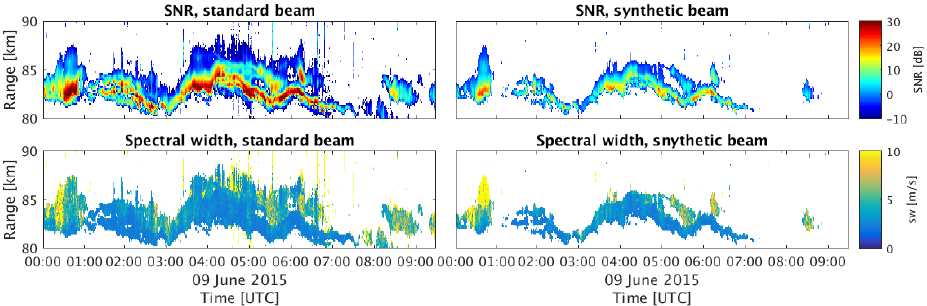
Figure 7. Comparison of spectral parameters obtained from the standard narrow beam, including side lobes (left column), and the synthetic narrow beam (right column). The synthetic narrow beam was obtained by gaining spectra for each virtual beam pointing direction k and average the resulting spectra only between − 1.8 and 1.8 ◦ . Comparing the SNR (first row), the echoes from the upper edges of PMSEs are removed in the main beam while the lower edges are in the same range. Signals with large spectral width (second row) due to side lobe detections are removed from the beam and increased spectral width to turbulence remains.